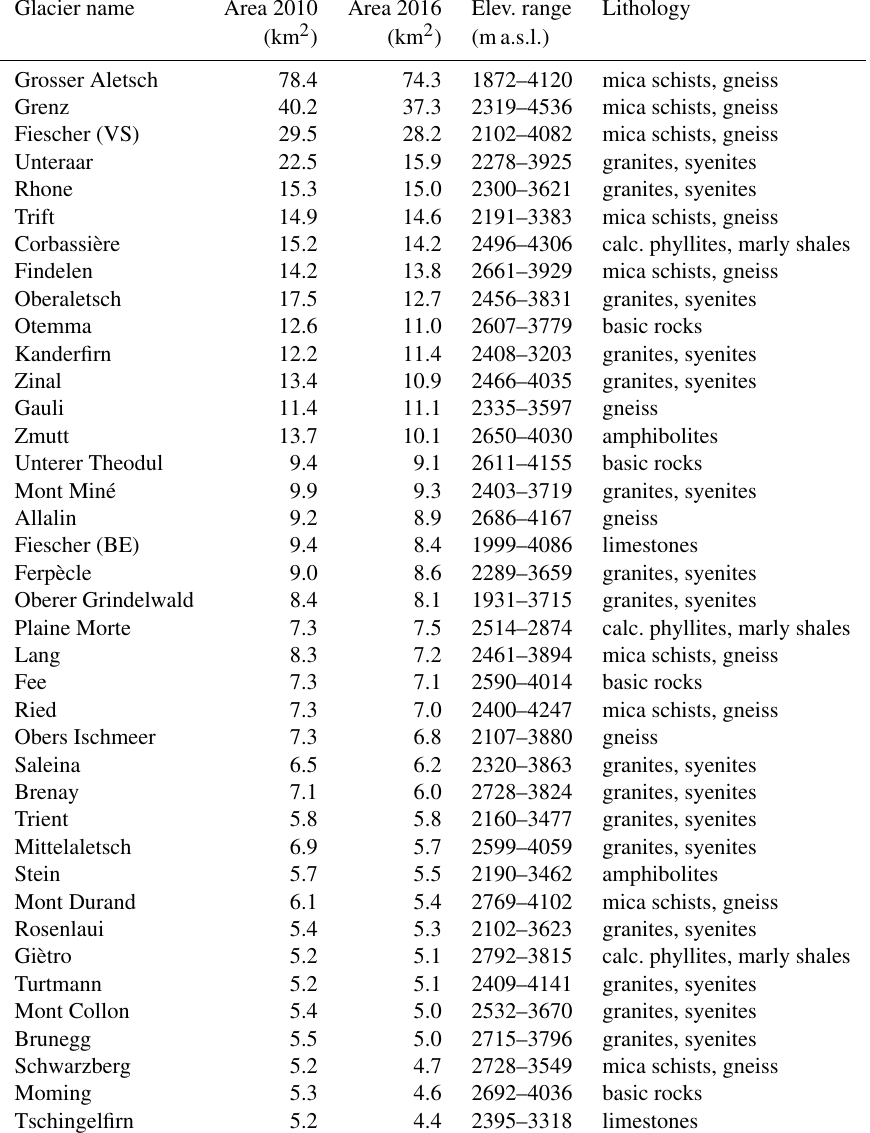
Table 1. Overview of all 39 study glaciers, their area (2010 according to Fischer et al., 2014, 2016 excluding thick debris coverage), elevation range and the lithology of rocks surrounding the glacier. Glaciers are ordered according to their surface